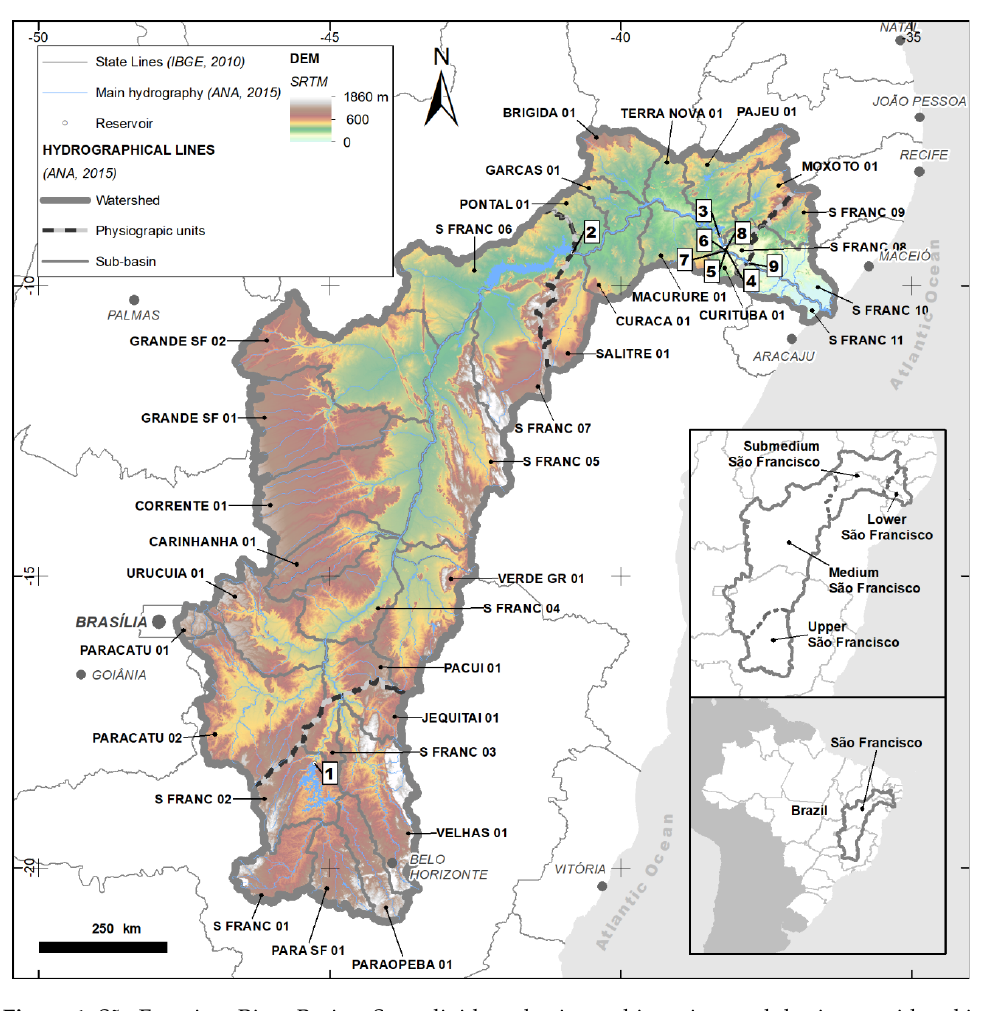
Figure 1. São Francisco River Basin—State divides, physiographic regions, sub-basins considered in the São Francisco River Basin Ten-year Plan (2004–2013), together with elevation (DEM) and main reservoirs: 1—Três Marias, 2—Sobradinho, 3—Itaparica, 4—Moxotó, 5—Paulo Afonso I, 6—Paulo Afonso II, 7—Paulo Afonso III, 8—Paulo Afonso IV, 9—Xingó. Source: adapted from Freitas et al.